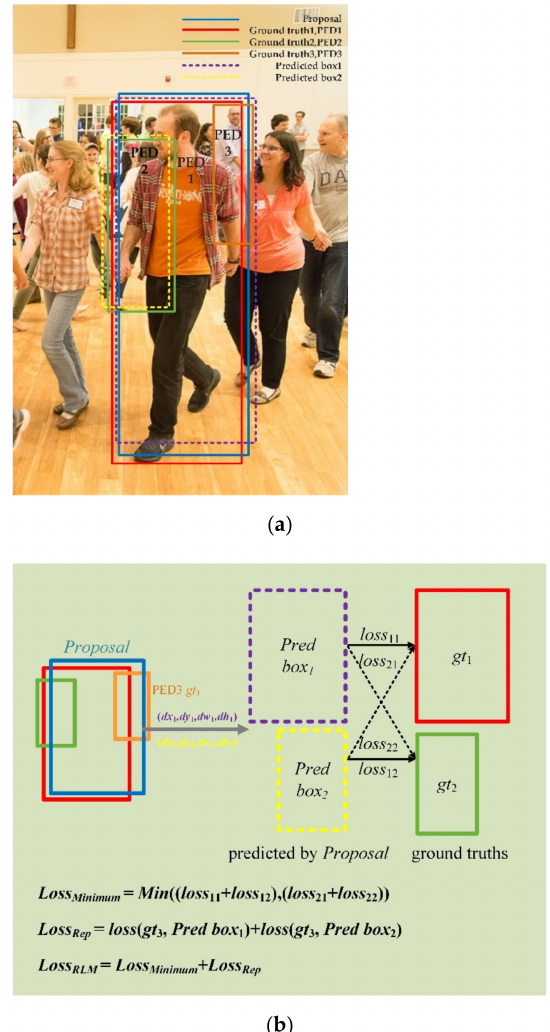
Figure 3. Repulsion loss of minimum. ( a ) Solid boxes(red, green and orange) except for the blue proposal represent ground truths. Dashed boxes (purple and yellow) indicate two predictions by the same blue proposal. ( b ) Dashed (purple and yellow) boxes are predicted boxes by the blue proposal B. Solid boxes, red, green and orange ( gt 1 , gt 2 , gt 3 ) are the ground truths that have the maximum IoU with the blue proposal. Calculate the loss between the orange box and yellow and purple boxes, resulting in Loss Rep